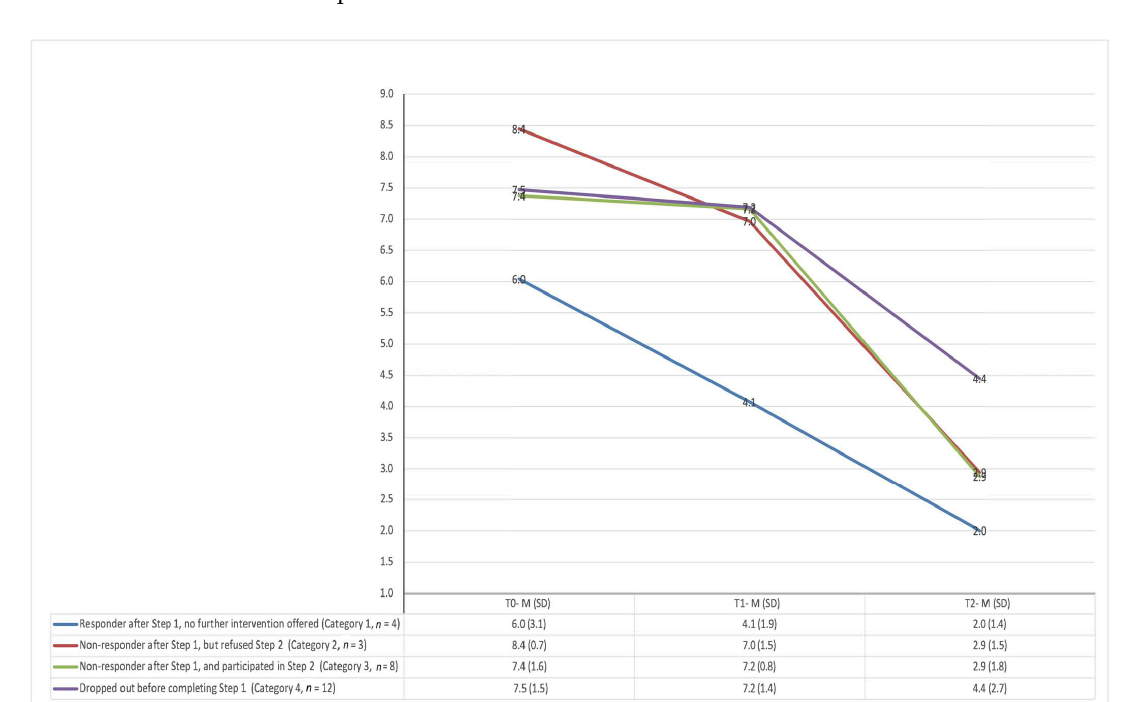
Figure 2. Youth Top Problem (YTP) average scores across three time points. The mean baseline RCADS T-score for the 27 participants with paired pre-post scores was 62.4 (SD = 14.2). Follow-up RCADS scores were similar across each of the four categories: Category 1 (M = 44.8, SD = 9.5), Category 2 (M = 44.4, SD = 4.1), Category 3 (M = 44.6, SD = 9.8), and Category 4 (M = 44.8, SD = 15.8).